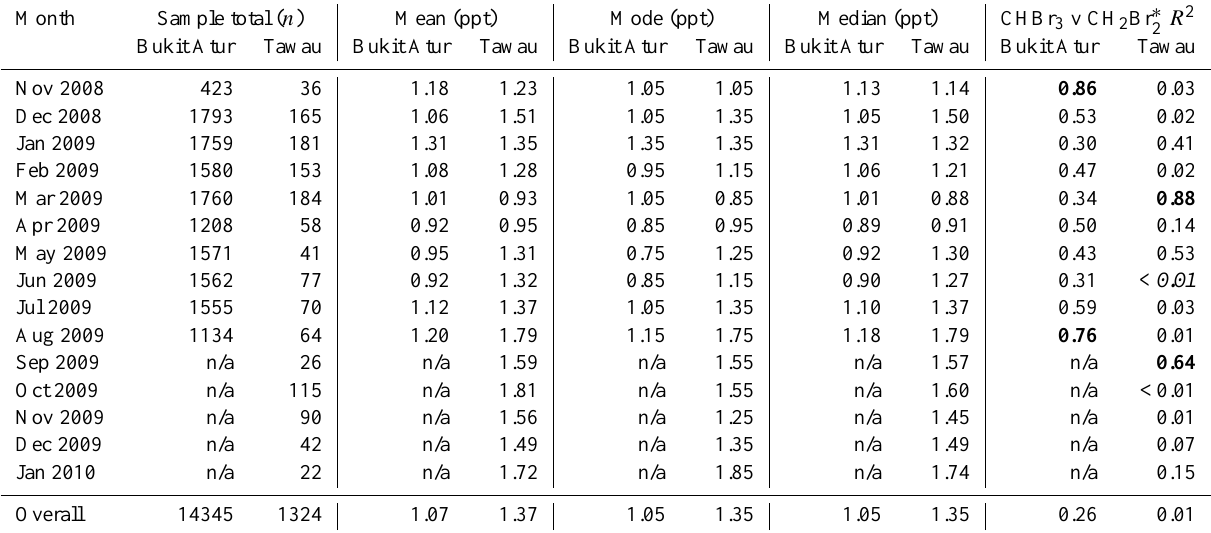
at Bukit Atur and Tawau. 2